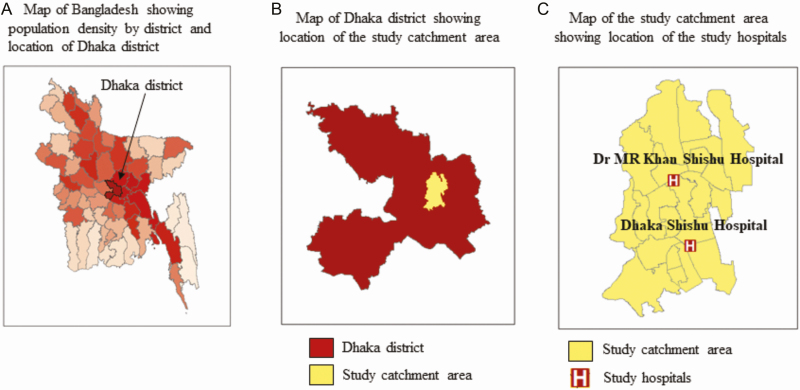
Maps showing population density in Bangladesh by (A) districts and location of Dhaka district, (B) location of the study catchment area in Dhaka district, and (C) location of the study hospitals in the study catchment area.